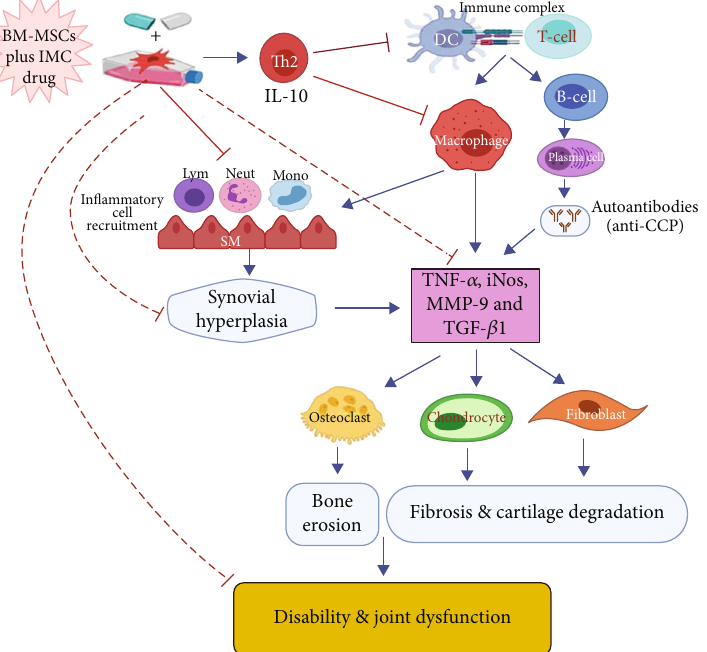
Figure 11: Schematic diagram showing the immunomodulatory e ff ect of BM-MSCs+IMC administered concurrently in CFA-induced arthritis. IMC: indomethacin; BM-MSCs: bone marrow-derived mesenchymal stem cells; Th2: T helper 2; DC: dendritic cell; IL-10: interleukin 10; T cell: T lymphocytes; B cell: B lymphocytes; Mono: monocytes; Neut: neutrophils; SM: synovial membrane; iNOS: inducible nitric oxide synthase; TGF- β 1: transforming growth factor-beta-1; TNF- α : tumor necrosis factor-alpha; anti-CCP: anticyclic citrullinated peptide antibody; MMP-9: matrix